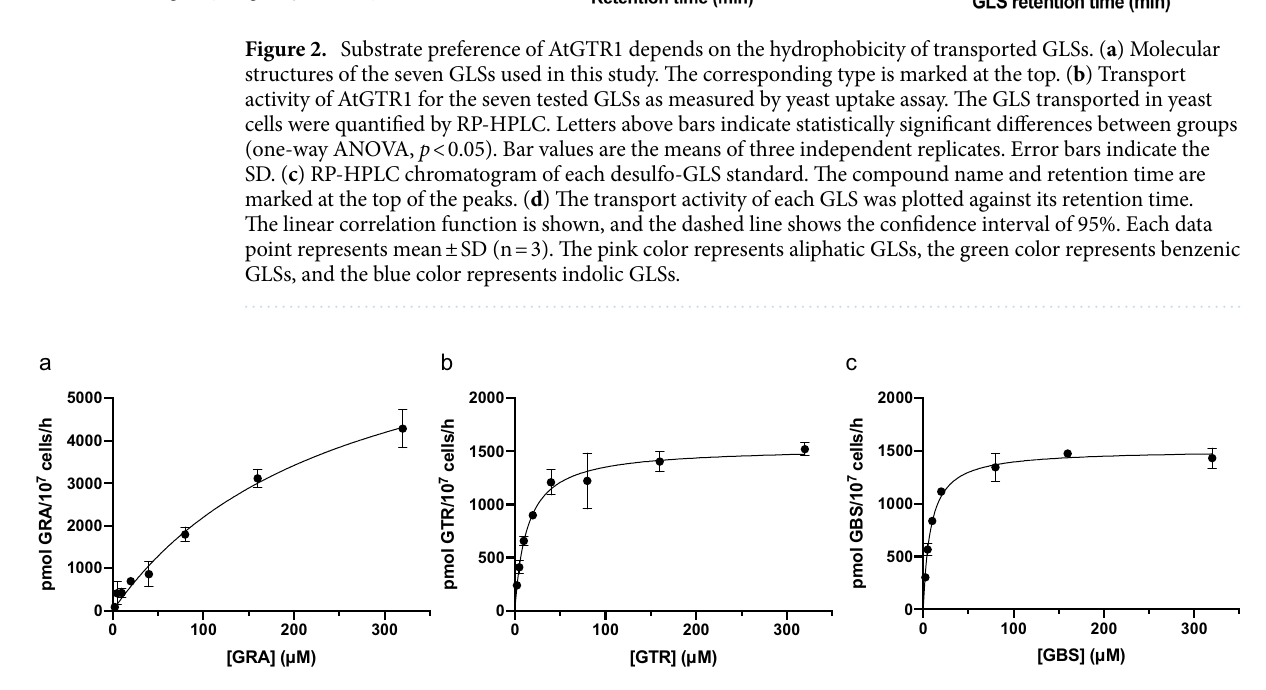
Figure 3. AtGTR1 showed high affinity and low efficiency for transporting GTR and GBS. The kinetic curve of AtGTR1 transporting ( a ) GRA, ( b ) GTR, and ( c ) GBS was measured by yeast uptake assay in the substrate concentration range of 2.5–320 μM. Michaelis–Menten kinetic curves were fitted using nonlinear regression, and the apparent K m for GRA, GTR, and GBS are 249.2, 13.6, and 8.2 μM, respectively. Each data point represents the mean of three independent replicates (mean ±